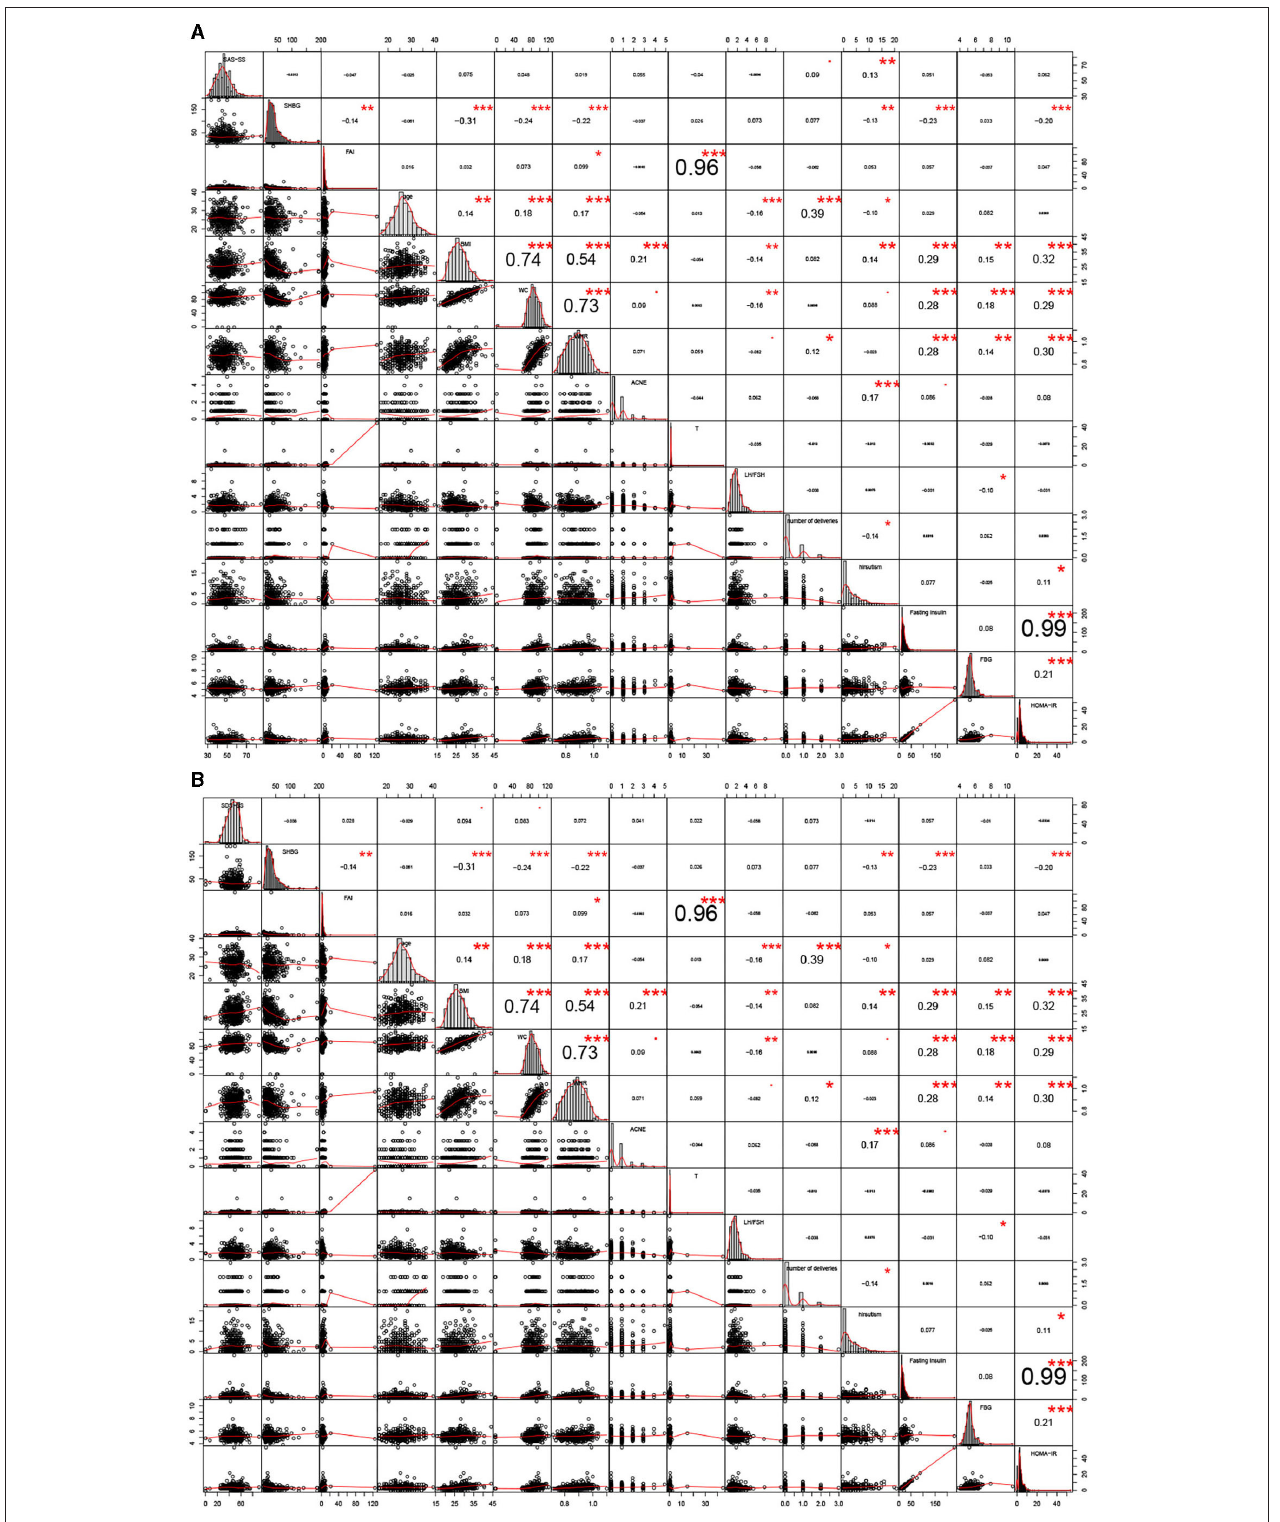
FIGURE 3 | Correlation analyses between anxiety/depression-like behaviors and the 14 clinical parameters in fertile group. * P < 0.05, ** P < 0.01, *** P < 0.005.